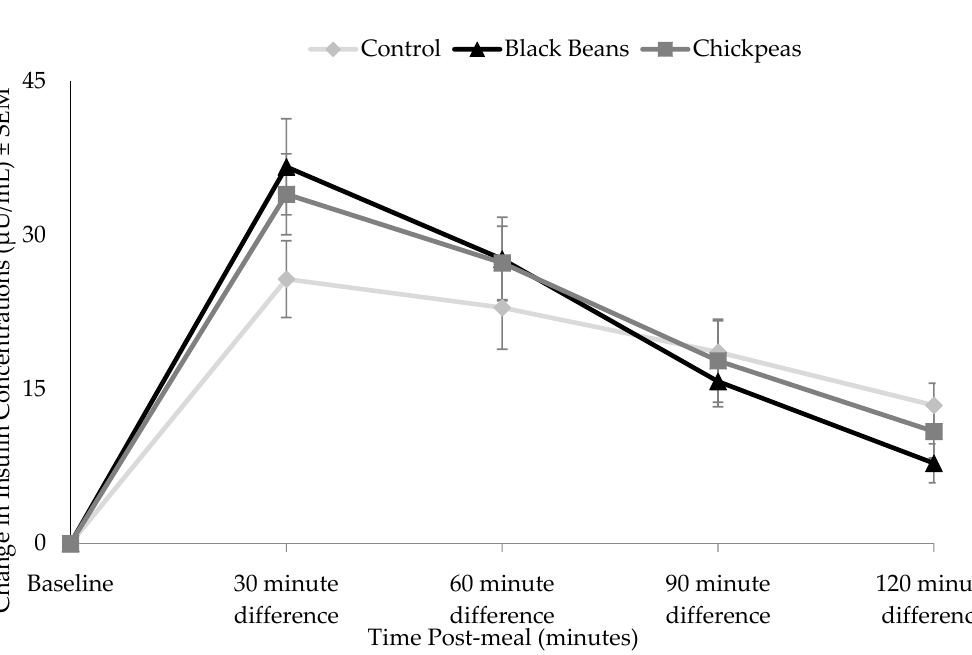
Figure 2. Effect of bean treatments on change in plasma insulin from fasting values. Points denote mean insulin concentration at each data collection timepoint and error bars denote standard error of means. Results of a post-hoc paired t-test indicated that the insulin response curve was significantly different at 30 ( p = 0.037) for black beans ( n = 12), and at 30 ( p = 0.026) for chickpeas ( n = 9) compared to the white rice control meal.